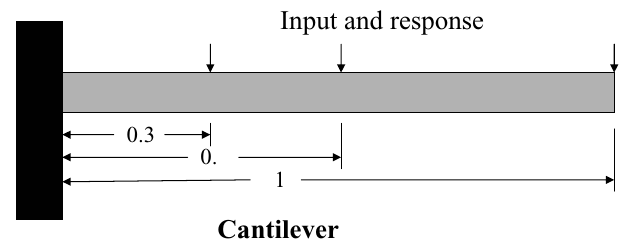
Fig. 17. Sketch of a cantilever beam used in an example.